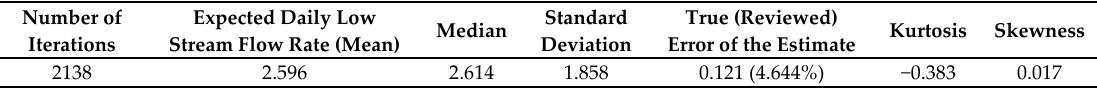
Table 1. Statistical criteria of Monte Carlo simulation for Perigiali Stream, Kavala city,